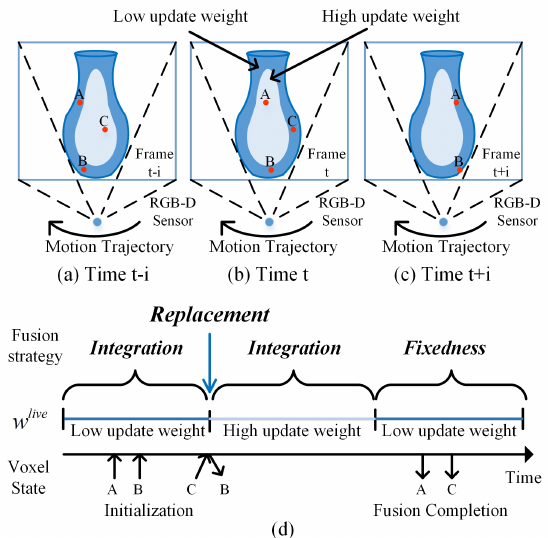
Figure 4. Our texture fusion strategy combines replacement, integration, and fixedness operation based on the updated weight of real-time frames. ( a – c ) represent the position of scene voxels “A”, “B”, and “C ”at di ff erent times and the estimated weight state of corresponding real-time frames, respectively. ( d ) represents the di ff erent state processes that the scene voxels may experience. The arrows represent the beginning and the end of voxel